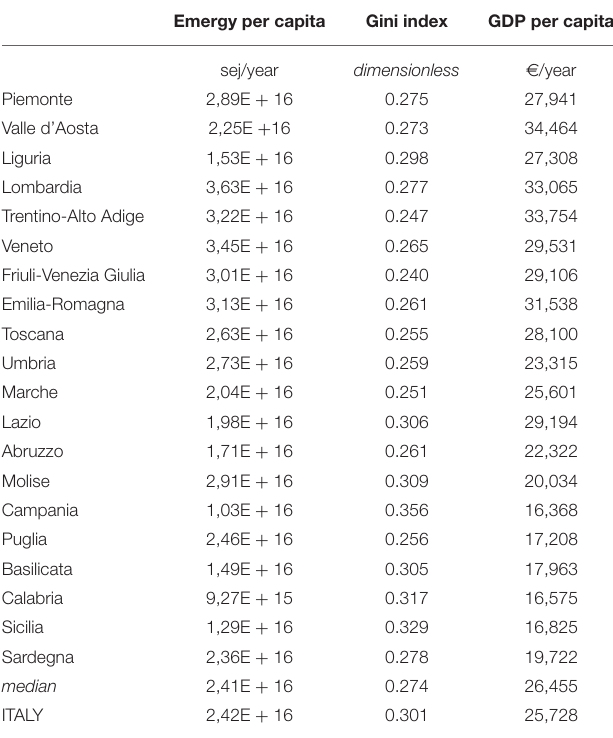
TABLE 1 | The values of the three indicators for regional systems and Italy in